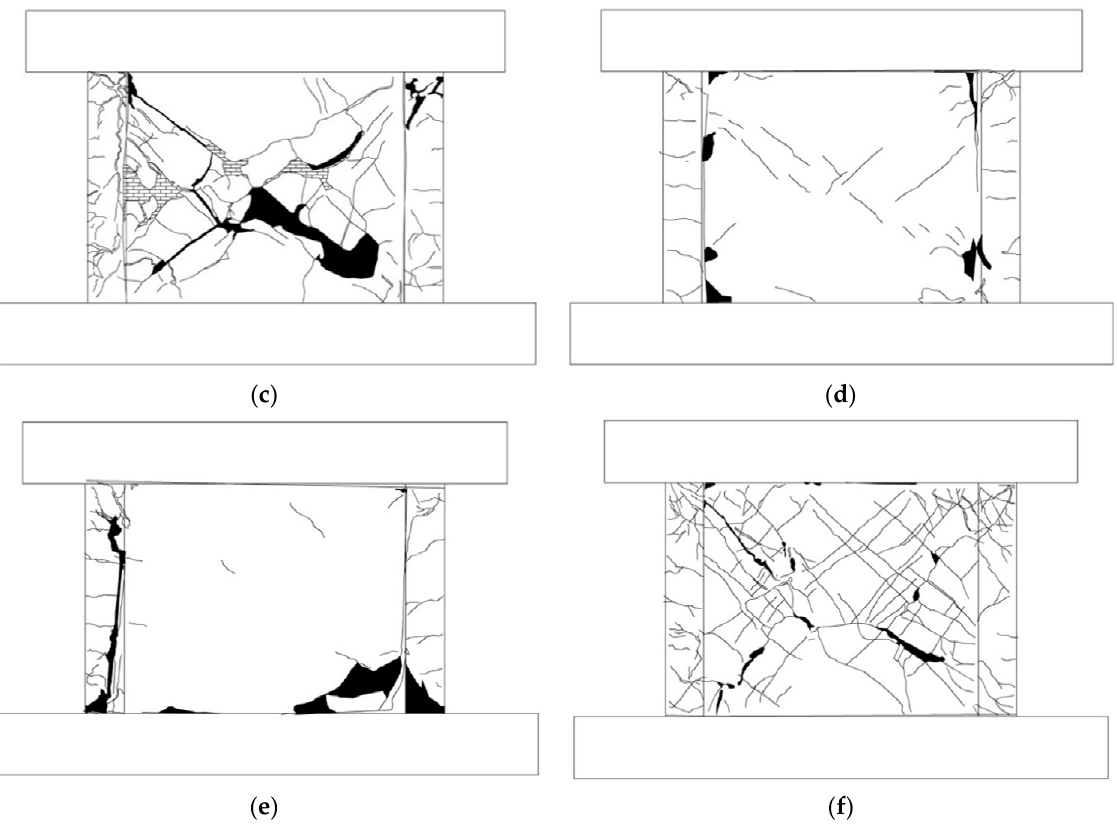
Figure 6. The cracking patterns of specimens at the drift angle R = 1/12.5: ( a ) IFSW specimen, ( b ) IFSM–A specimen, ( c ) IFSM–P specimen, ( d ) IFSM–S specimen, ( e ) IFSM–FRP specimen, and ( f ) IFSM–PW specimen.